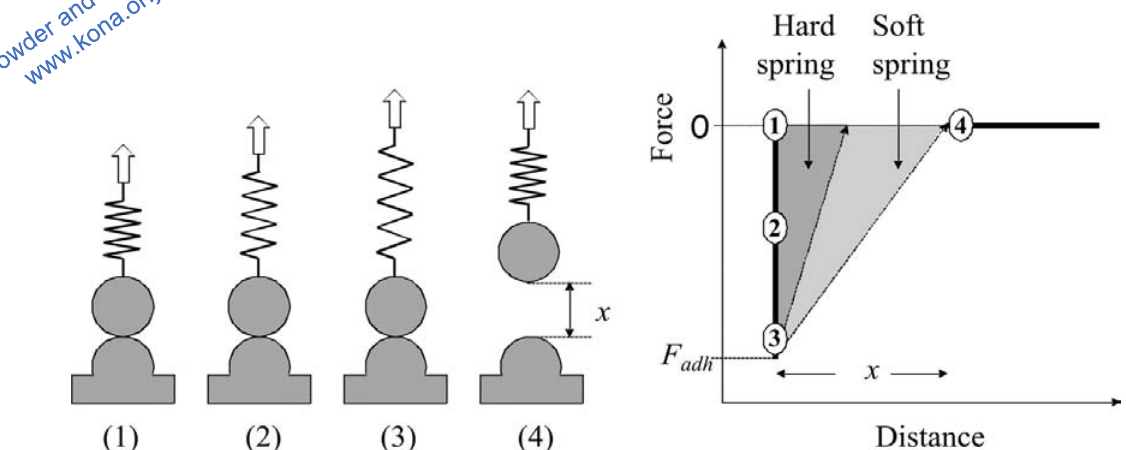
Fig. 2 Schematic of two particles adhering to each other. One is rigidly fixed to a substrate. With a spring the second particle is moved away from the first one. The corresponding force-versus-distance plot is schematically shown on the right.